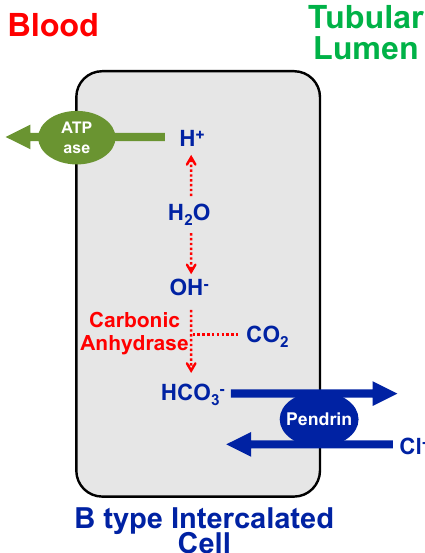
Figure 1. Sketch depicting a B type intercalated cell (also termed ß-intercalated cells) in the kidney cortical collecting duct and the connecting tubule. This cell expresses the Cl − /HCO 3 − exchanger pendrin on the tubular plasma membrane, and the H + -ATPase (= H + -pump) on the basolateral (“blood”) plasma membrane. Metabolic acidosis downregulates pendrin expression and therefore tends to reduce bicarbonate secretion. On the other hand, metabolic alkalosis upregulates pendrin and therefore tends to secrete bicarbonate into the tubular lumen.